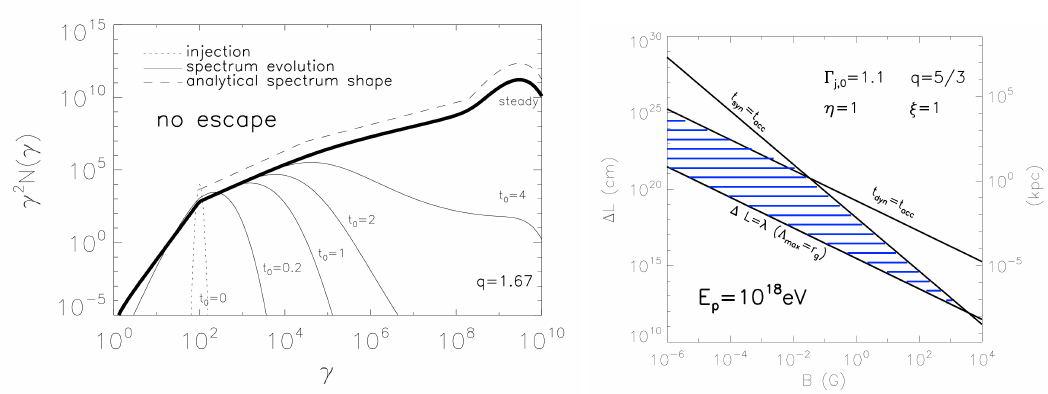
Figure 7. Left: Time-evolution of the electron spectrum, γ 2 n ( γ ) , in the presence of stochastic-shear particle acceleration, where n ( γ ) ∝ γ 2 f ( γ ) represents a solution of the corresponding Fokker-Planck equation for a linearly decreasing (trans-relativistic) velocity shear of width ∆ l ∼ r j /10, and an Alfven speed β A ∼ 0.007. Above particle Lorentz factors of a few times 10 4 the spectrum is shaped by shear acceleration, with a high-energy spectral cut-off around γ ∼ 10 9 being introduced by synchrotron losses. The successive operation of different acceleration processes here naturally results in a broken-power law distribution. Right: Required (blue-hatched) range of parameters (magnetic field strength B , shear layer width ∆ l ) to allow shear acceleration of protons to ∼ 10 18 eV given confinement and loss constraints for the noted conditions. The required conditions might be met in large-scale AGN jets. From Ref.